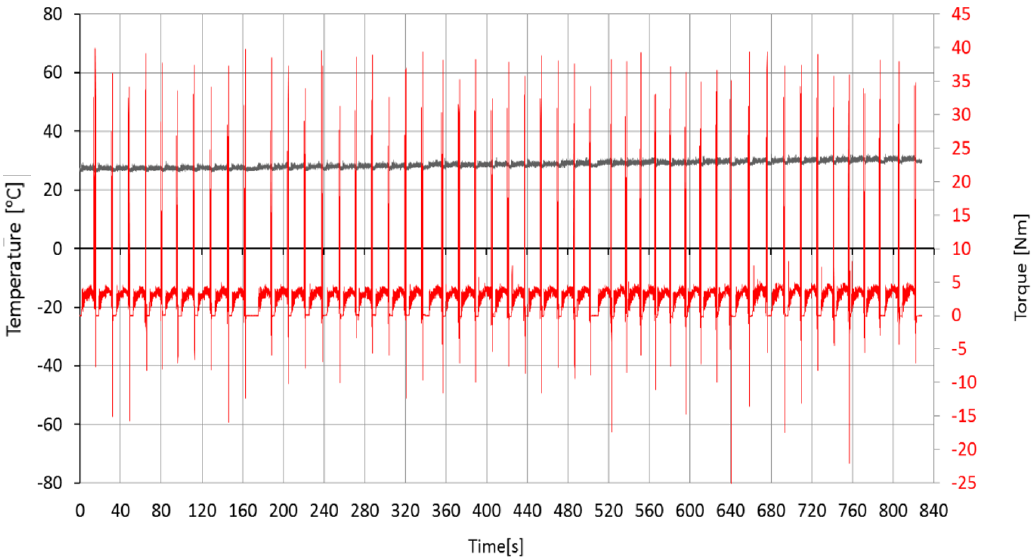
Figure 17. Jammings captured by the sensor between the brake and the torque limiter that show the output torque.